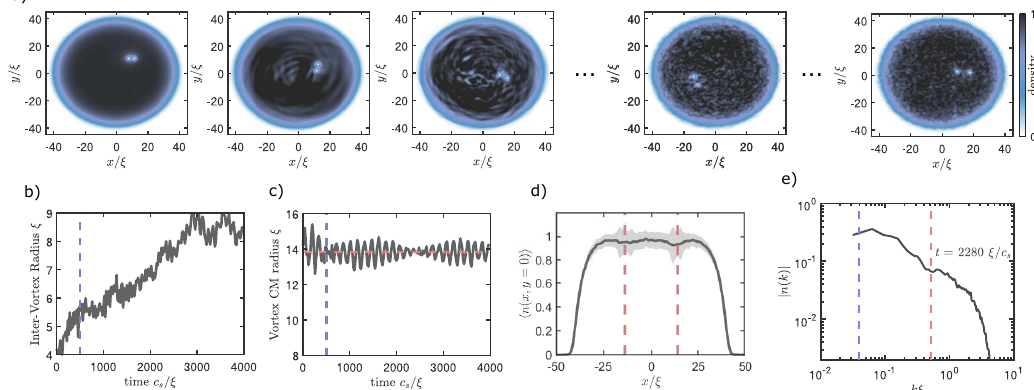
Figure 1. (color online) Panel ( a ) depicts a typical simulation. The first three plots correspond to t = 0, 250, 500 ξ / c s , during the shaking of the external potential. The remaining density maps depict later stages, at t = 2000, 4000 ξ / c s , respectively, where vortices evolve a fully developed turbulent background. Notice that the vortex dipole precesses around the trap axis due to the total content of orbital angular momentum in the system. The inter-vortex distance and the dipole centre-of-mass distance to the trap axis is plotted in panels ( b , c ), respectively. Here, the vertical blue line corresponds to the end of the potential shaking step, while the red line in panel ( c ) depicts the average CM distance. In panel ( d ) we plot the density profile across a slice y = 0, with (cid:104)(cid:105) denoting time average (during the entire simulation span) and the red lines indicating the average CM distance, as before. Moreover, the shaded are corresponds to the one sigma level of density fluctuations. Panel ( e ) depicts the power spectrum of the density fluctuations for a particular time instant, with the blue and red lines indicating the scales associated with the size of the trap and mean inter-vortex radius.